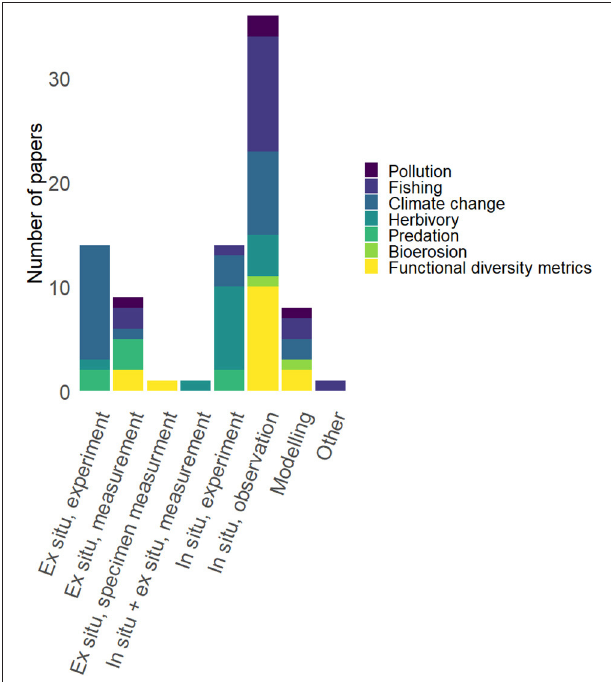
FIGURE 4 | Number of papers (colored according to disturbance, process, or functional diversity) in each evidence